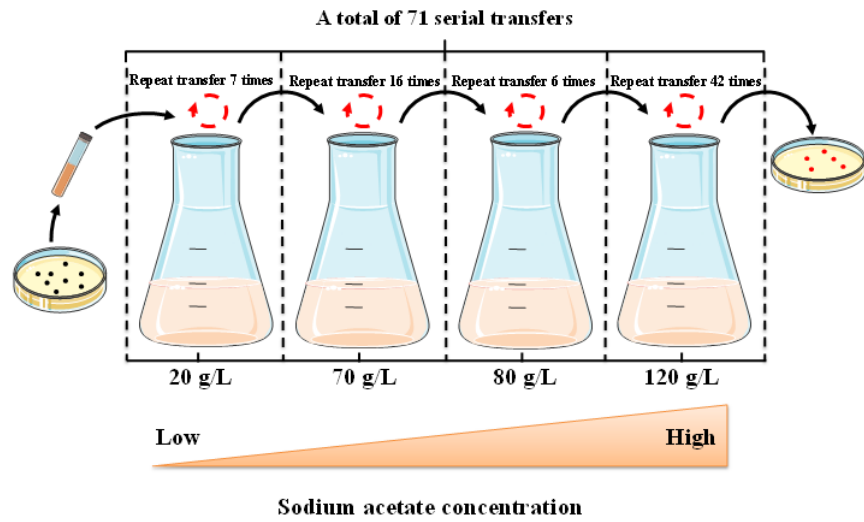
Figure 1. Adapted cultivation of H. bluephagenesis TD1.0. The single colony (black spot) was serially transferred in 60 MMA medium with increasing concentrations of sodium acetate, and, finally, evolved colonies (red spot) were isolated on 60 MMA solid plates containing 120 g/L sodium acetate.